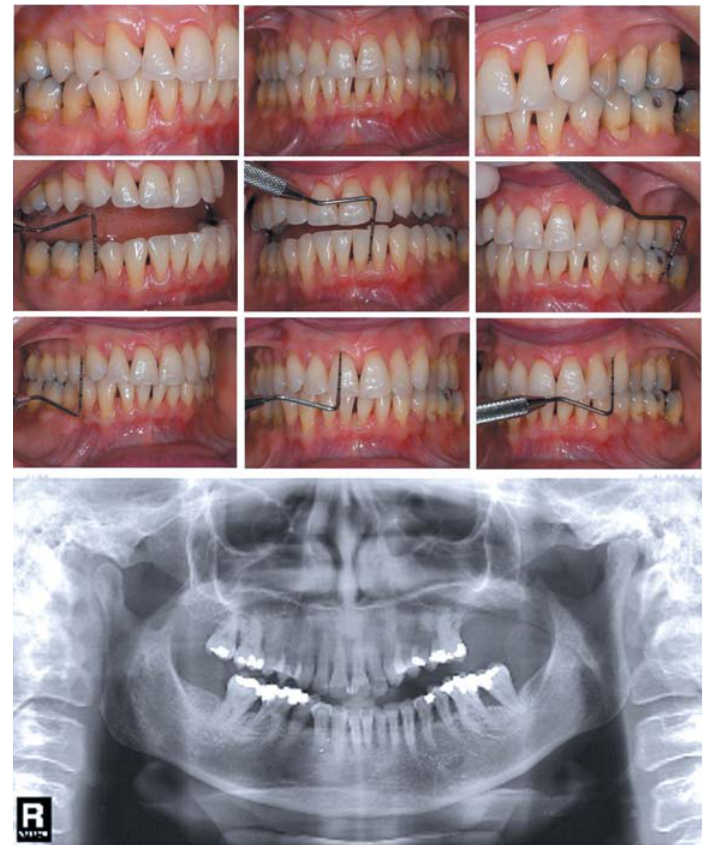
Figure 6- (cid:2)(cid:3)(cid:4)(cid:5)(cid:6)(cid:5)(cid:7)(cid:8)(cid:4)(cid:2)(cid:8)(cid:6)(cid:21)(cid:2)(cid:13)(cid:8)(cid:21)(cid:5)(cid:15)"(cid:13)(cid:8)(cid:23)(cid:16)(cid:5)(cid:7)(cid:2)(cid:9)(cid:10)(cid:8)(cid:11)(cid:12)(cid:13)(cid:10)(cid:14)(cid:2)(cid:15)(cid:9)(cid:2)(cid:11)(cid:16)(cid:10)(cid:2)(cid:6)(cid:15)(cid:6)(cid:17)(cid:5)(cid:6)(cid:18)(cid:8)(cid:19)(cid:19)(cid:8)(cid:11)(cid:15)(cid:13)(cid:20)(cid:2)(cid:21)(cid:10)(cid:14)(cid:11)(cid:13)(cid:12)(cid:7)(cid:11)(cid:5)(cid:22)(cid:10)(cid:2)(cid:23)(cid:10)(cid:13)(cid:5)(cid:15)(cid:21)(cid:15)(cid:6)(cid:11)(cid:8)(cid:4)(cid:2)(cid:21)(cid:5)(cid:14)(cid:10)(cid:8)(cid:14)(cid:10)(cid:2)(cid:24)(cid:25)(cid:26)(cid:27)(cid:28)(cid:27)(cid:29)(cid:2)(cid:7)(cid:8)(cid:14)(cid:10)(cid:2)(cid:24)^(cid:2) years follow-up). Satisfactory oral hygiene, with no apparent plaque formation, accumulation of gross calculus or gingivitis (cid:31)(cid:8)(cid:14)(cid:2)(cid:15)!(cid:14)(cid:10)(cid:13)(cid:22)(cid:10)(cid:21)(cid:30)(cid:2)<!(cid:14)(cid:10)(cid:6)(cid:7)(cid:10)(cid:2)(cid:15)(cid:9)(cid:2)!(cid:4)(cid:10)(cid:10)(cid:21)(cid:5)(cid:6)"(cid:2)(cid:15)(cid:6)(cid:2)(cid:23)(cid:13)(cid:15)!(cid:5)(cid:6)"#(cid:2)(cid:8)!(cid:14)(cid:10)(cid:6)(cid:7)(cid:10)(cid:2)(cid:15)(cid:9)(cid:2)%&(cid:2)(cid:19)(cid:19)(cid:2)(cid:23)(cid:13)(cid:15)!(cid:5)(cid:6)"(cid:2)(cid:21)(cid:10)(cid:23)(cid:11)(cid:16)(cid:14)#(cid:2)(cid:8)(cid:6)(cid:21)(cid:2)(cid:11)(cid:16)(cid:10)(cid:2)(cid:23)(cid:13)(cid:10)(cid:14)(cid:10)(cid:6)(cid:7)(cid:10)(cid:2)(cid:15)(cid:9)(cid:2)(cid:4)(cid:15)(cid:7)(cid:8)(cid:4)(cid:5)’(cid:10)(cid:21)(cid:2)"(cid:5)(cid:6)"(cid:5)(cid:22)(cid:8)(cid:4)(cid:2) recession are also depicted. The alveolar bone status concerning the generalized horizontal alveolar bone loss can be observed and considered stable when compared with initial radiographic